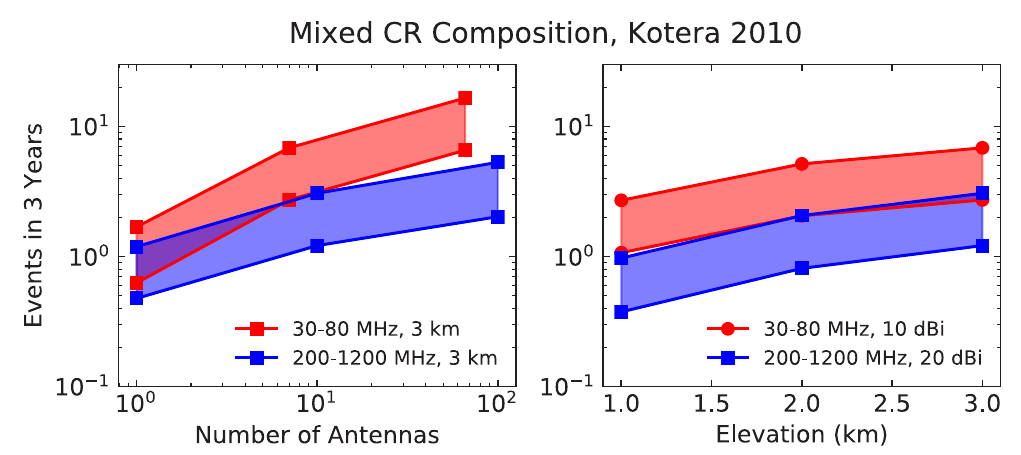
Figure 1. Left : A 10 17 eV τ shower emerging at a 5 ◦ and decaying at the exit point generates a radio beam pattern shown here as the SNR versus θ v ie w, deca y . The radio emission is filtered in the 30-80 MHz (red) and 200-1200 MHz bands (blue) for 1 antenna (solid) and 10 phased antennas (dot-dashed). Right : The acceptance of 10 mountaintop radio detectors to ν τ ’s compared to IceCube’s acceptance to ν τ ’s [5] and the Pierre Auger Observatory’s Figure 2. The number of events recorded in 3 years on 10 stations overlooking rock with a 120 ◦ field-of-view, acceptance to Earth-skimming ν τ ’s [6]. assuming the range of cosmogenic models with mixed cosmic ray composition from Ref. [7]. (Left) The detector elevation is fixed at 3 km, but the number of antennas per station varies. (Right) The number of antennas is fixed at 7 for VHF and 10 for UHF, while varying the station